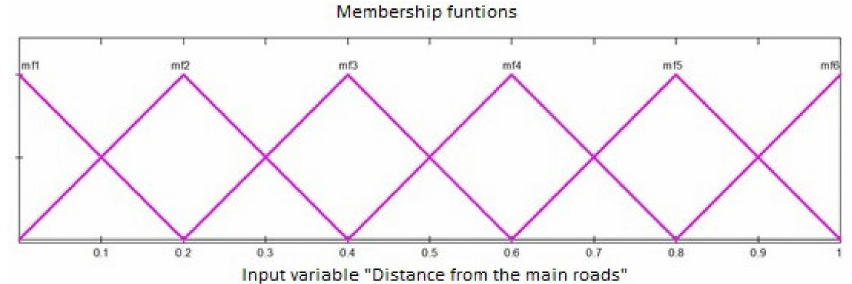
Figure 15. MFs of the input variable “Distance from the main roads”. Slope